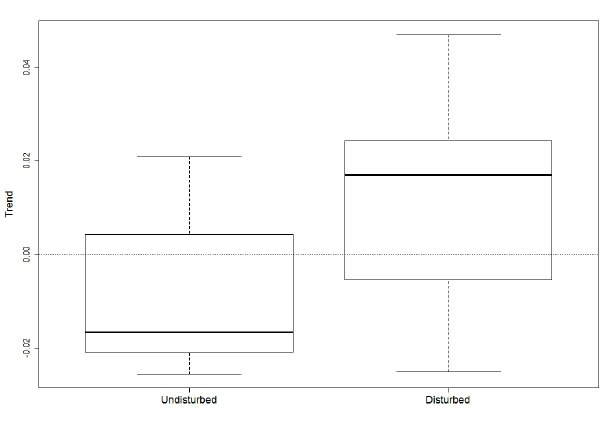
Fig. 7. Mourning Warbler abundance trends in undisturbed (decreasing) and disturbed (increasing) stands between circa 1994 and 2014. Boxplots depict median (solid line) and 25th to 75th percentiles of the data (box), and whiskers are ± 1.5 times the interquartile range. Stands were considered disturbed if we noted the presence of any disturbance (e.g., fire, forest harvest, or windthrow) in the stand.